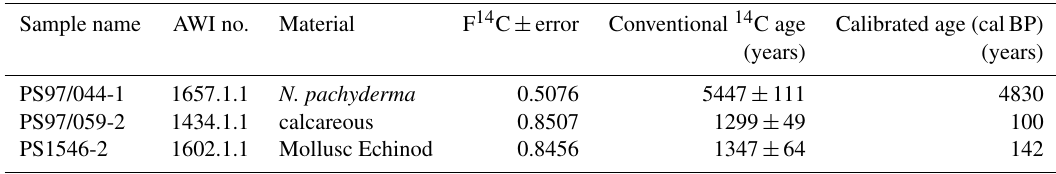
Table 3. Details of the radiocarbon dates and calibrated